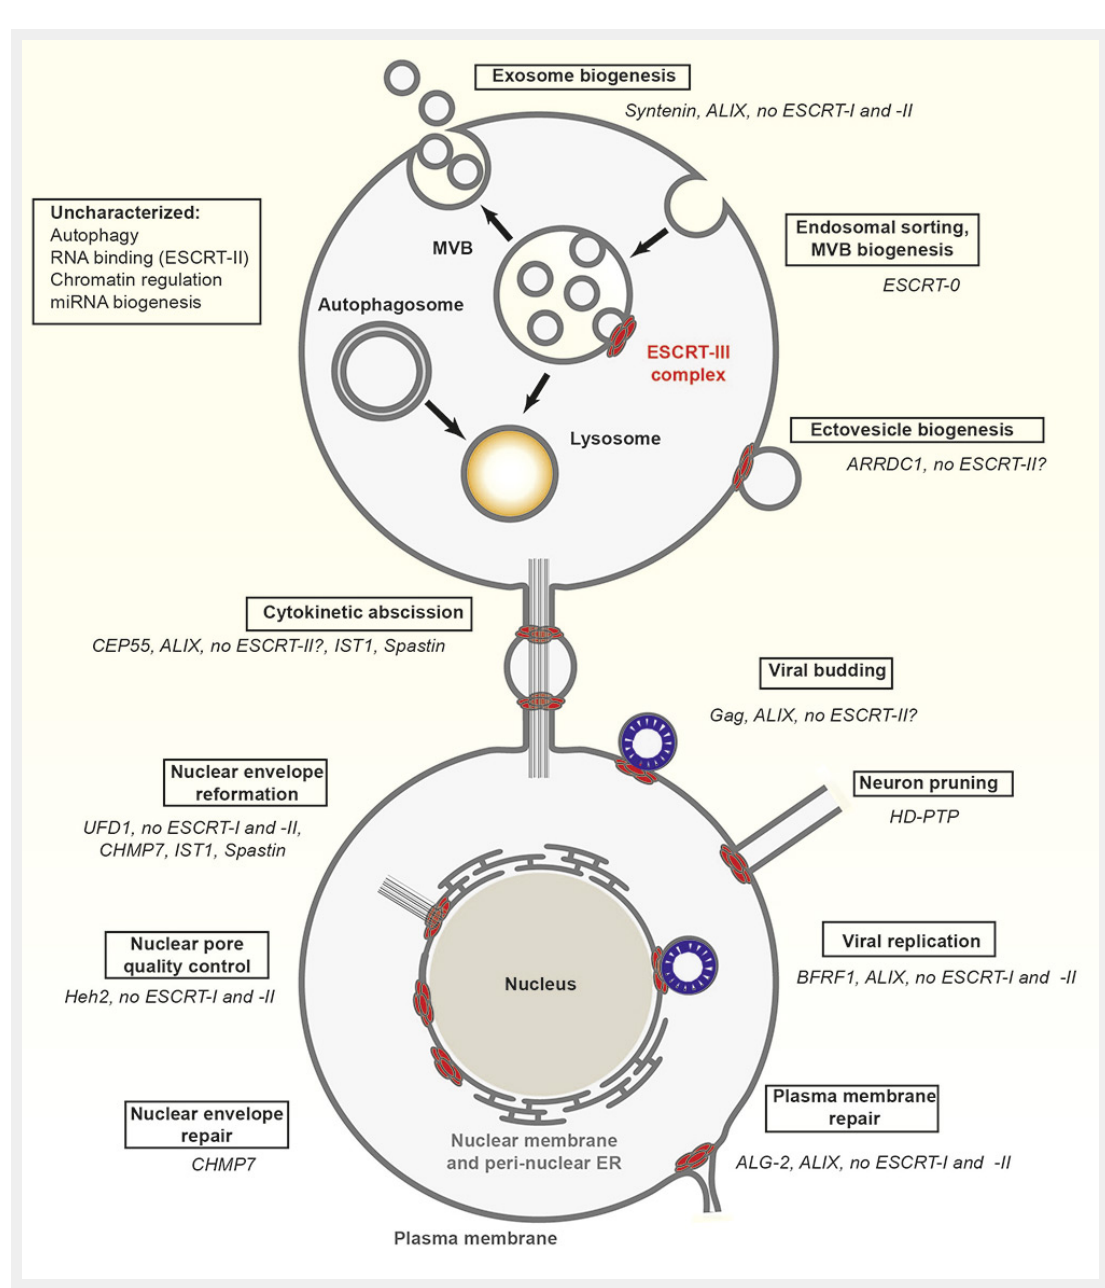
Cell biological functions of ESCRTs (endosomal sorting complexes required for transport). Overview of ESCRT functions throughout the cell. Factors that are specific for each ESCRT-dependent process (boxed) are listed in